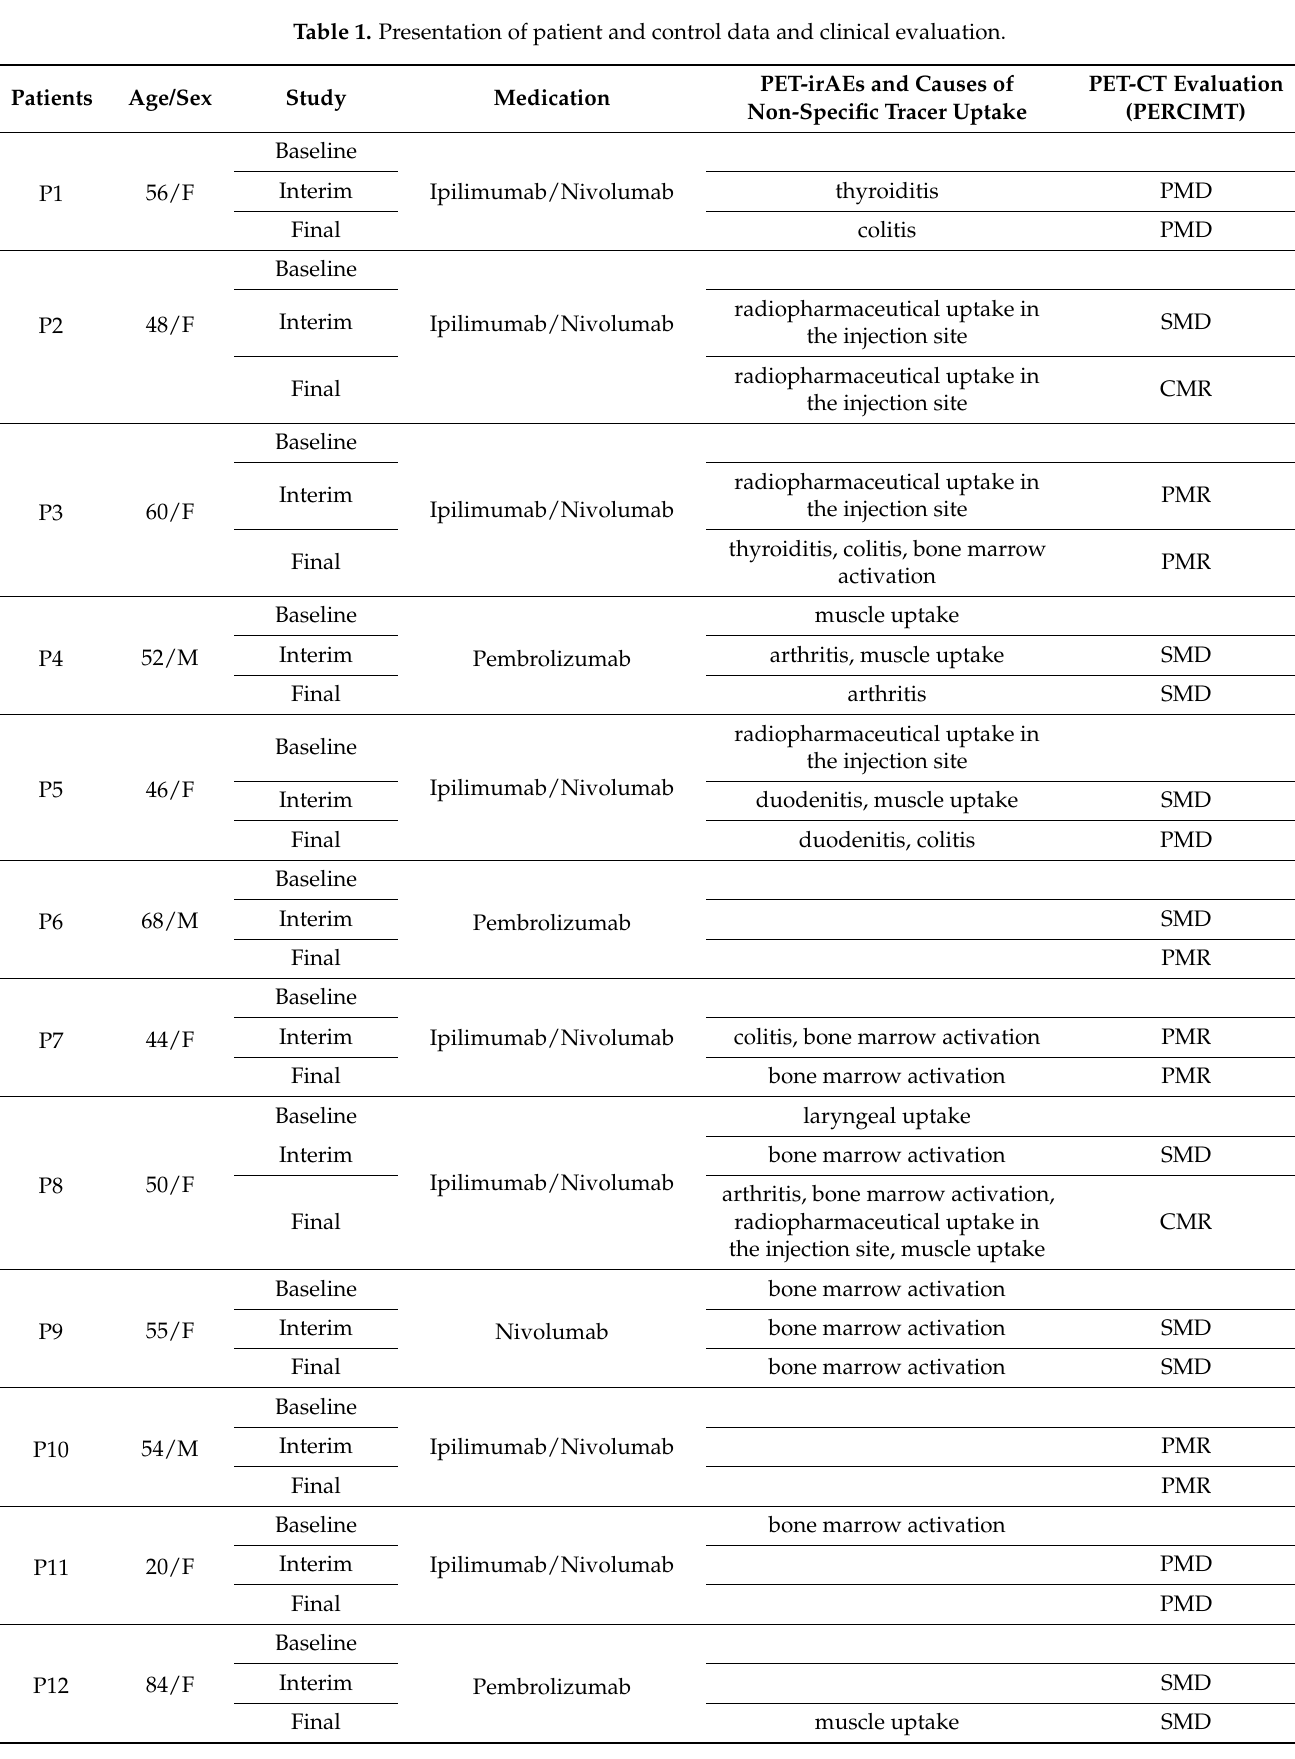
Table 1. Presentation of patient and control data and clinical